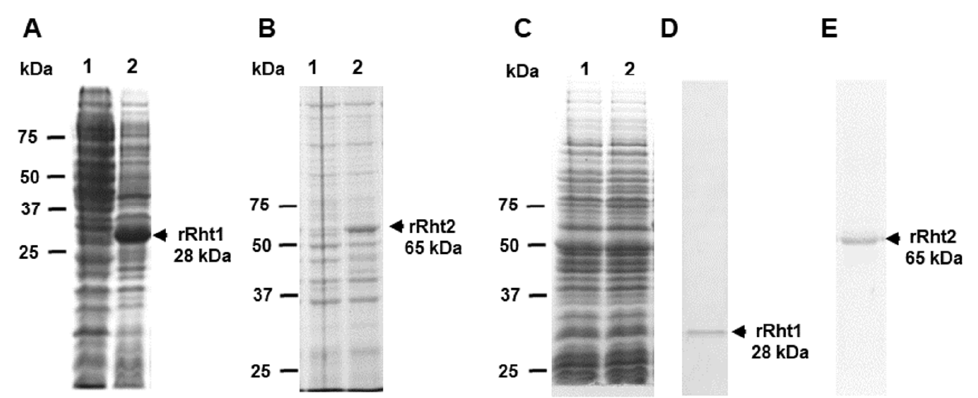
Figure 2. Electrophoretic profile of recombinant Rht1 and Rht2 expressed in Escherichia coli . Bacteria were transformed with pCold-RHT1 ( A ), pCold-RHT2 ( B ), or empty pCold I ( C ) and grown under non-inducive conditions (lanes 1) or in inducing conditions (lanes 2, 0.1 M isopropyl- β -D-1-thiogalactopyranoside and 20 h at 20 °C). Protein samples were prepared from cultured cells and separated by denaturing SDS-PAGE. The recombinant proteins rRht1 ( D ) and rRht2 ( E ) were then subjected to purification by affinity chromatography using a cobalt-charged resin. Panel A corresponds to an electrophoretic analysis in 12% acrylamide gel, while gels of 10% acrylamide were used in panels ( B – E ).